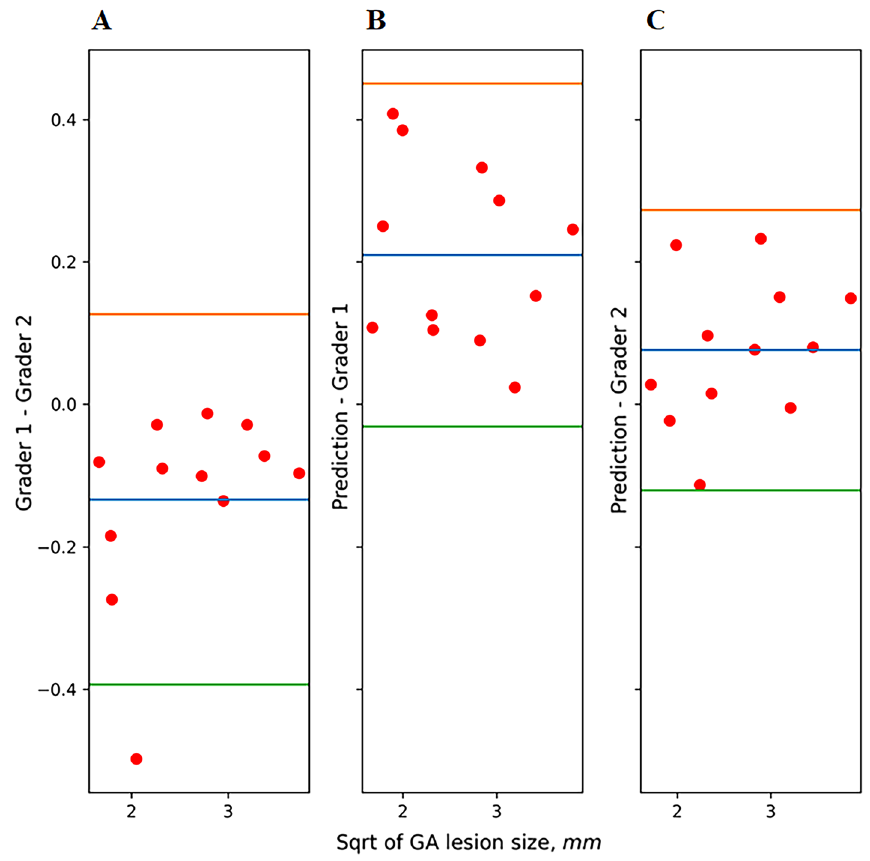
Figure 1. Limits of agreement for inter-grader agreement ( A ) and model-grader ( B , C ) agreements of the total geographic atrophy lesion size. The mean difference is plotted in blue and the limits of agreement are plotted in orange (mean difference + 1.96 standard deviation of the difference) and green (mean difference − 1.96 standard deviation of the difference). Sqrt square root transformation. Grader 1 slightly underestimated GA lesion size compared to grader 2. The model performance was closer to grader 2 than to grader 1. The limits of agreement were wider for the inter-grader agreement than for the model-grader agreements, showing that the AI model operated within inter-grader